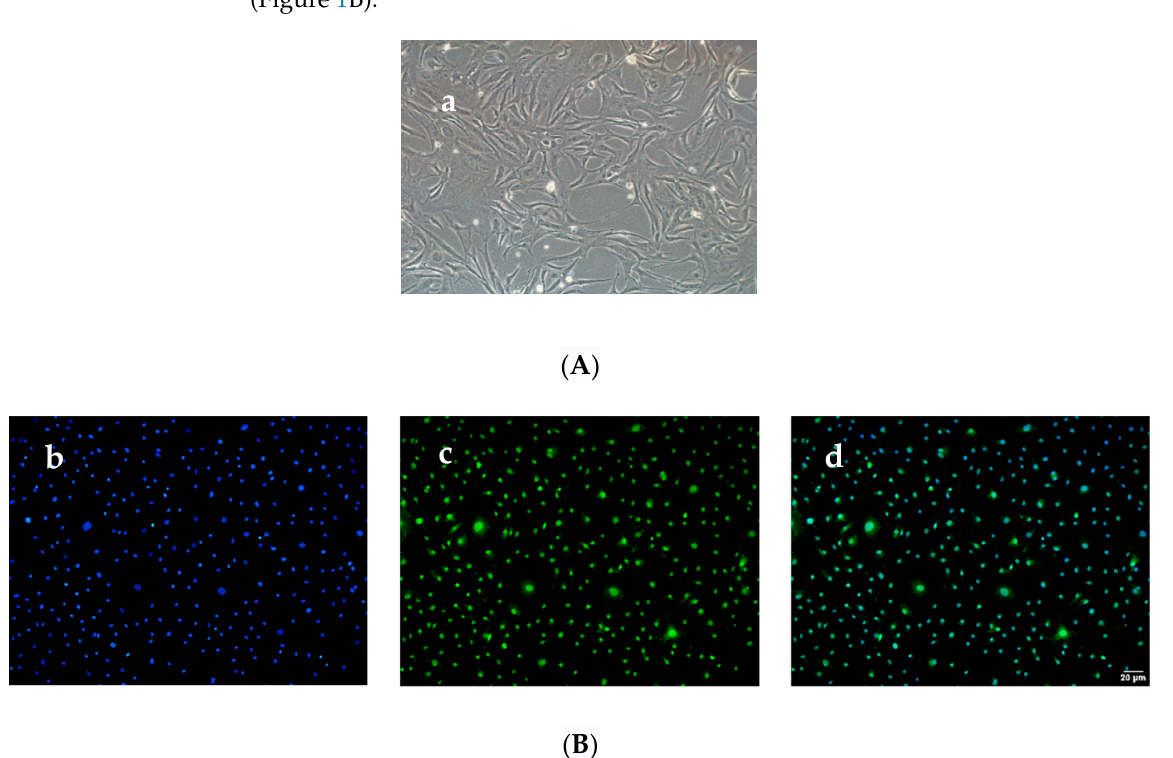
Figure 1. Buffalo GCs culture and identification: ( A ) ( a ): The morphology of buffalo GCs was observed under the microscope. ( B ) Identification of buffalo GCs by cellular immunofluorescence. ( b ): Cell nucleus were stained by DAPI (blue), ( c ): Cell nucleus and cell membranes were stained by FSHR (green), ( d ): Merge of ( b ) and ( c ).